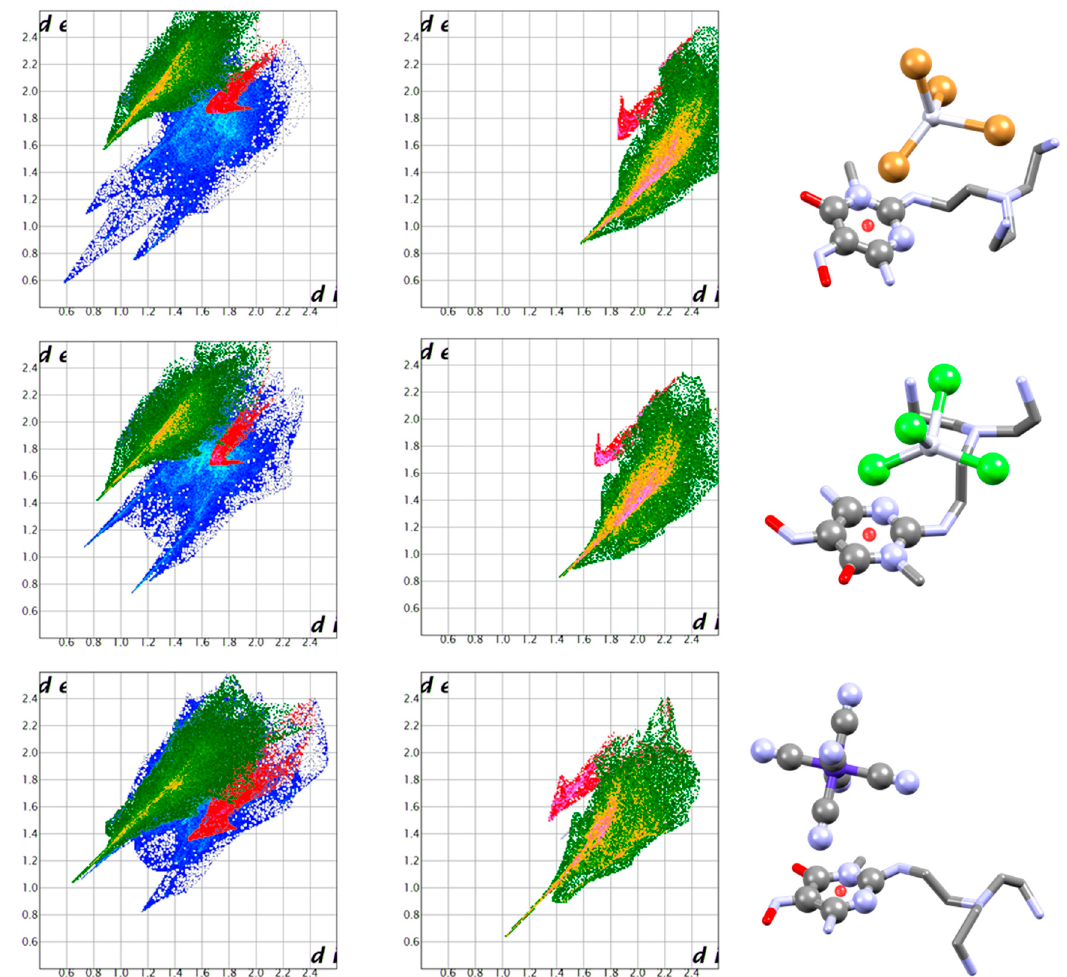
Figure 12. Complexes of the diprotonated 6-amino-2-((2-(bis(2-aminoethyl)amino)ethyl)amino)-3-methyl-5-nitrosopyrimidin-4(3 H )-one ligand, bearing a functionalised pyrimidine residue, with HgBr 42 − (CSD refcode AVISEE [50]), HgCl 42 − (AVISII [50]) and Co(CN) 63 − (IDIKAJ [51]) anions. Ligand and anion fingerprint plots, together with a brief view of the structure, are presented for each one. All anions are bound via H-bonds (green) and anion- π interactions (red). The two contributions are markedly different and clearly recognisable.